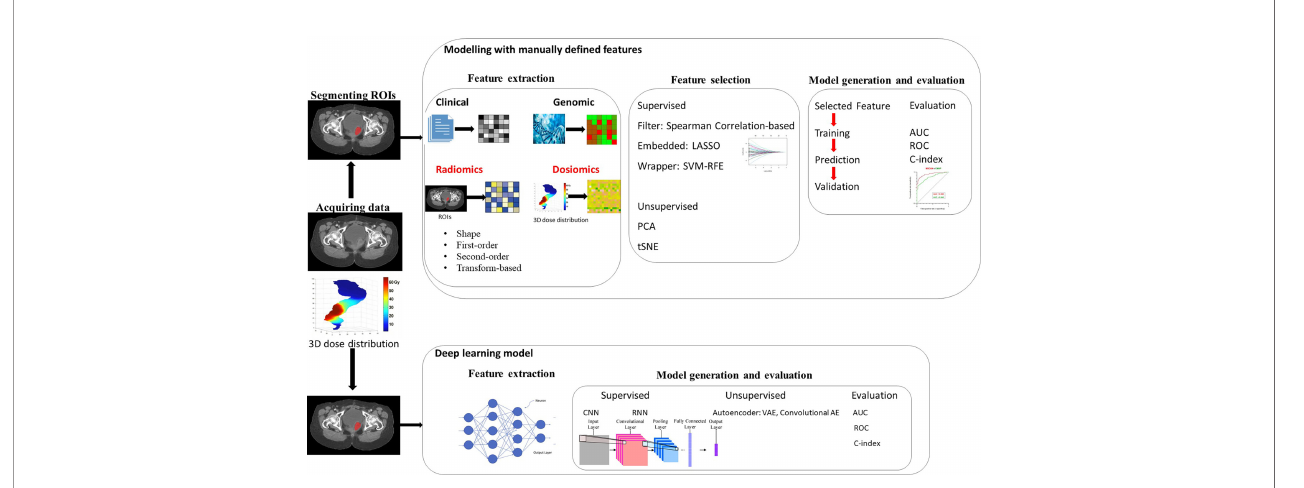
FIGURE 1 | Work fl ow for radiomics and dosiomics analysis with feature-based (machine learning) and featureless (deep learning)